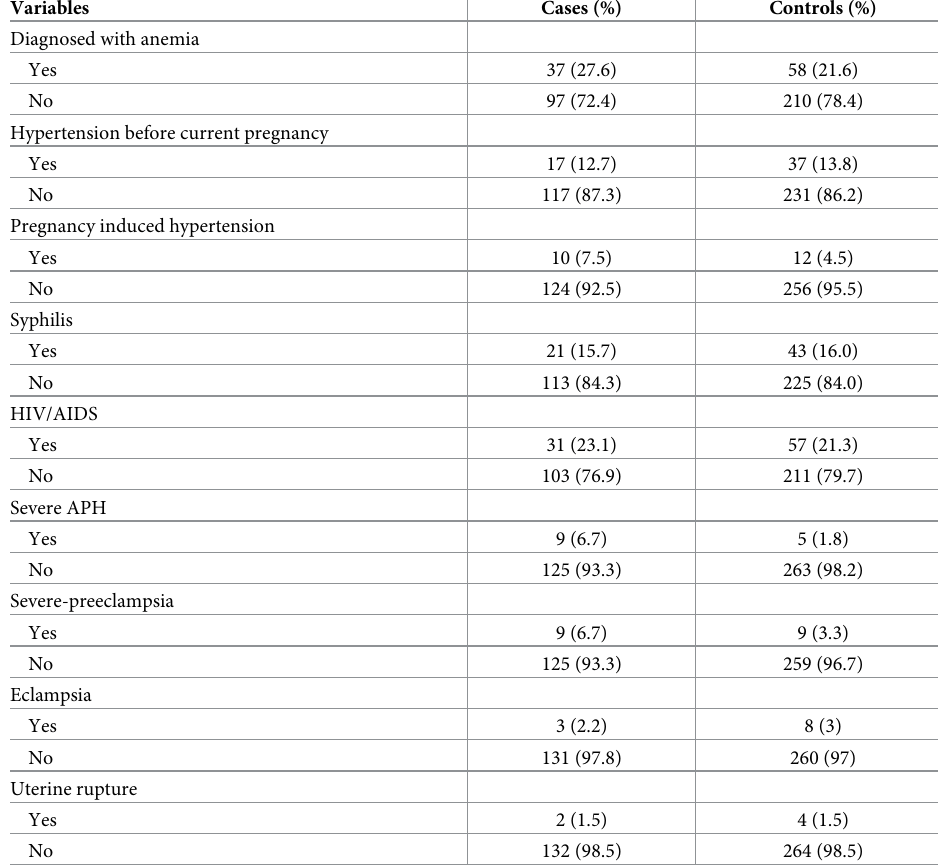
Table 3. Chronic medical history of neonate’s mother who gave live birth in Guji and Borena Zones selected Pub- lic Hospitals, Southern Ethiopia,